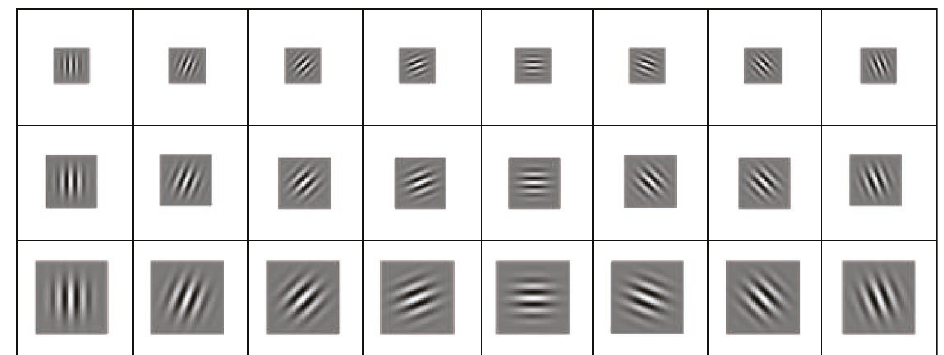
Figure 2: The real part of the Gabor filters with three scales and eight